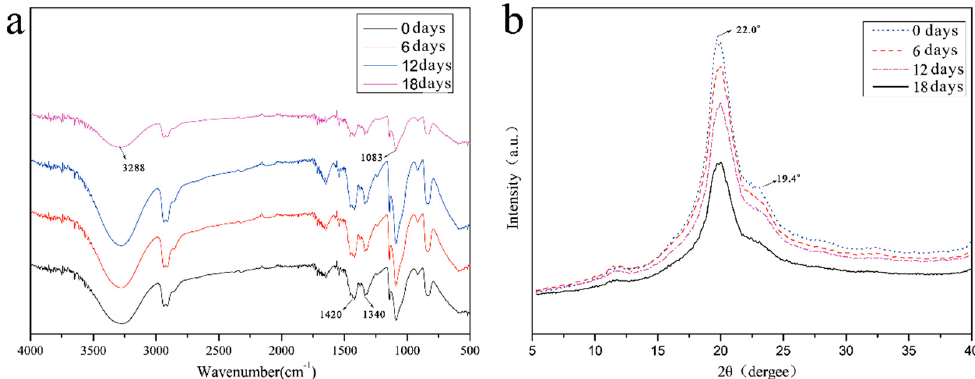
Figure 5. Chemical structures of artificial skin samples: ( a ) FT–IR curves of the exact location of the artificial skin on day 0, day 6, day 12, and day 18 of the self-healing process, and ( b ) XRD curves of the same location of the artificial skin on day 0, day 6, day 12, and day 18 of the self–healing process.